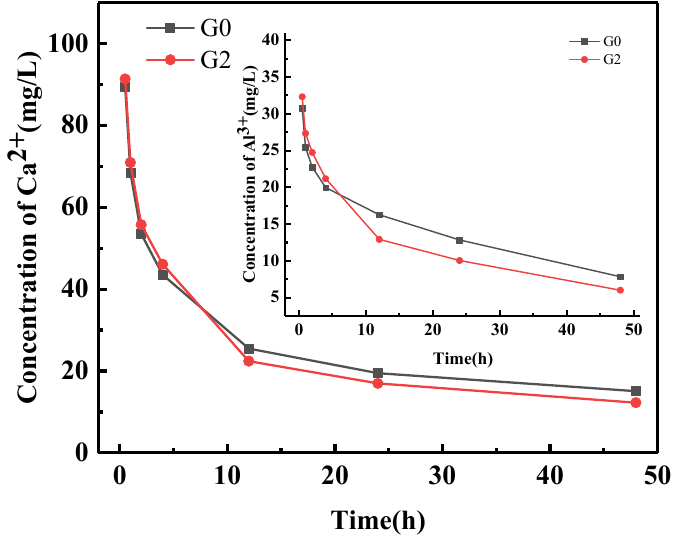
Figure 8. ICP results of sulfoaluminate cement paste.